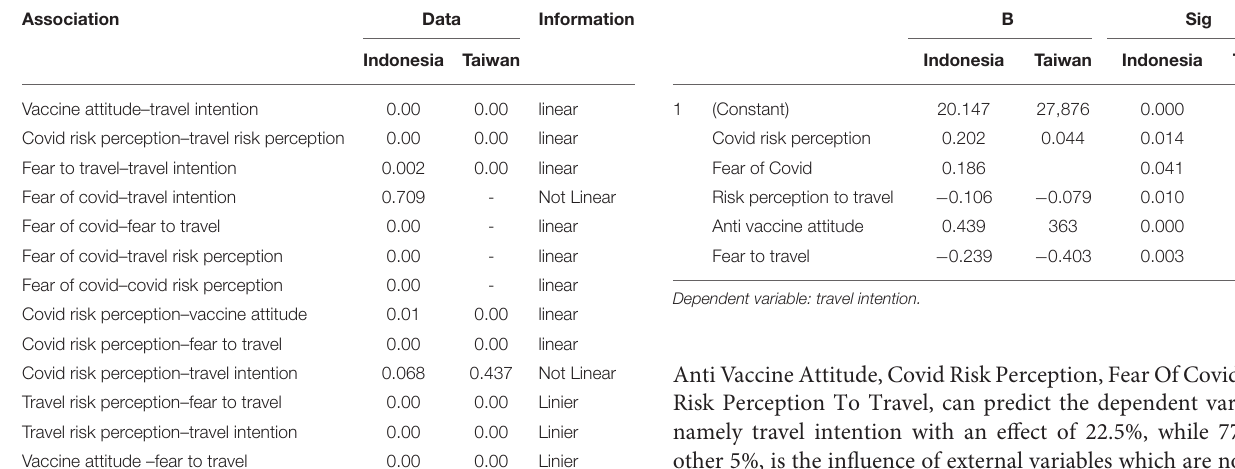
TABLE 6 | Partial test of the independent variable on the dependent